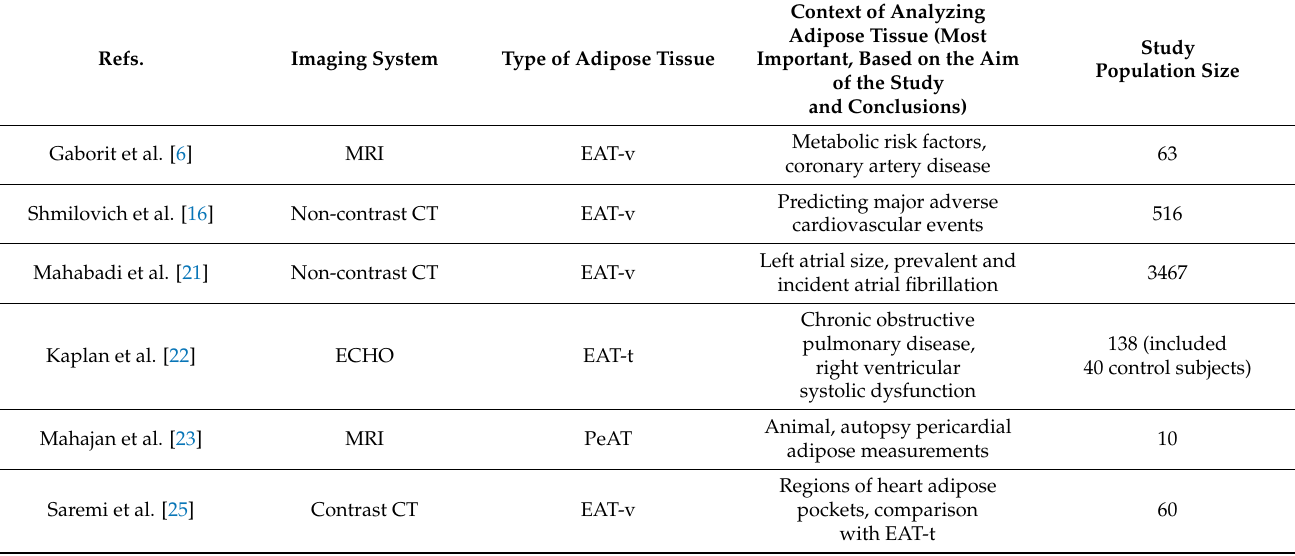
Table 1. Studies focused on heart adipose